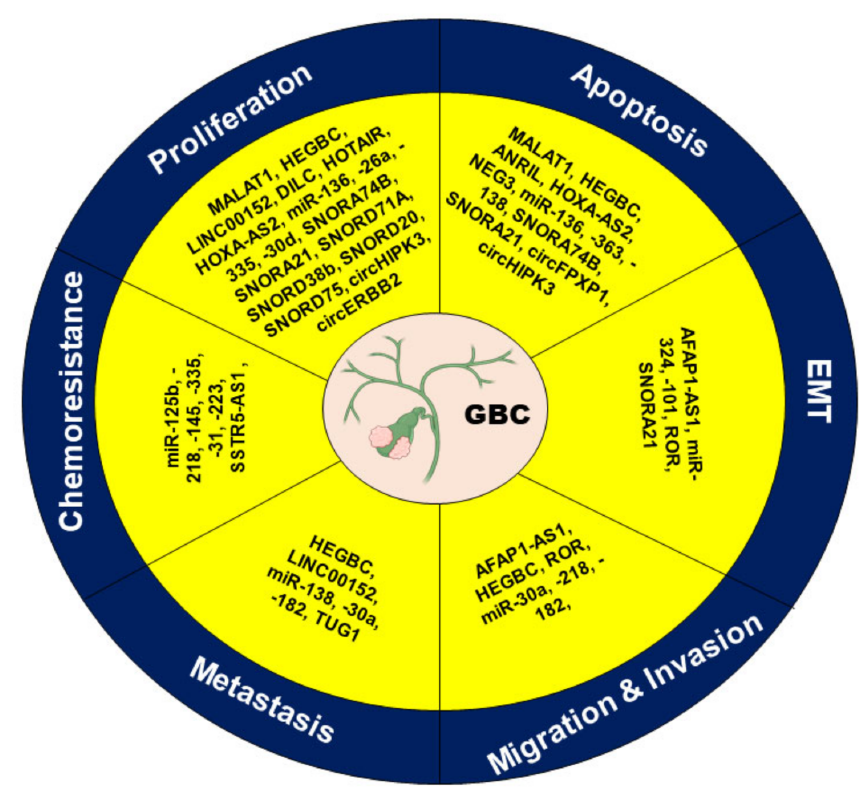
Figure 3. Different ncRNAs modulating the critical hallmarks in